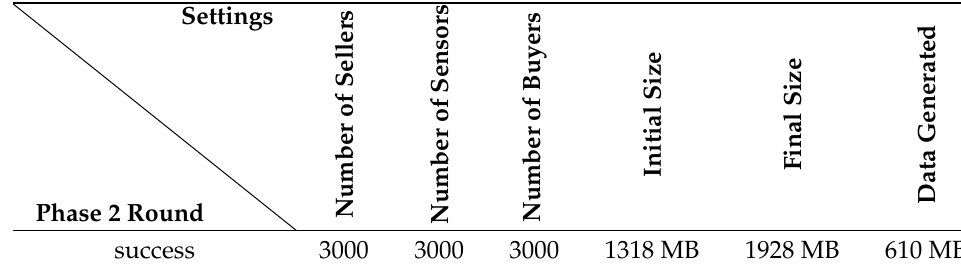
Table 8. Peer data generation in successful Phase 2